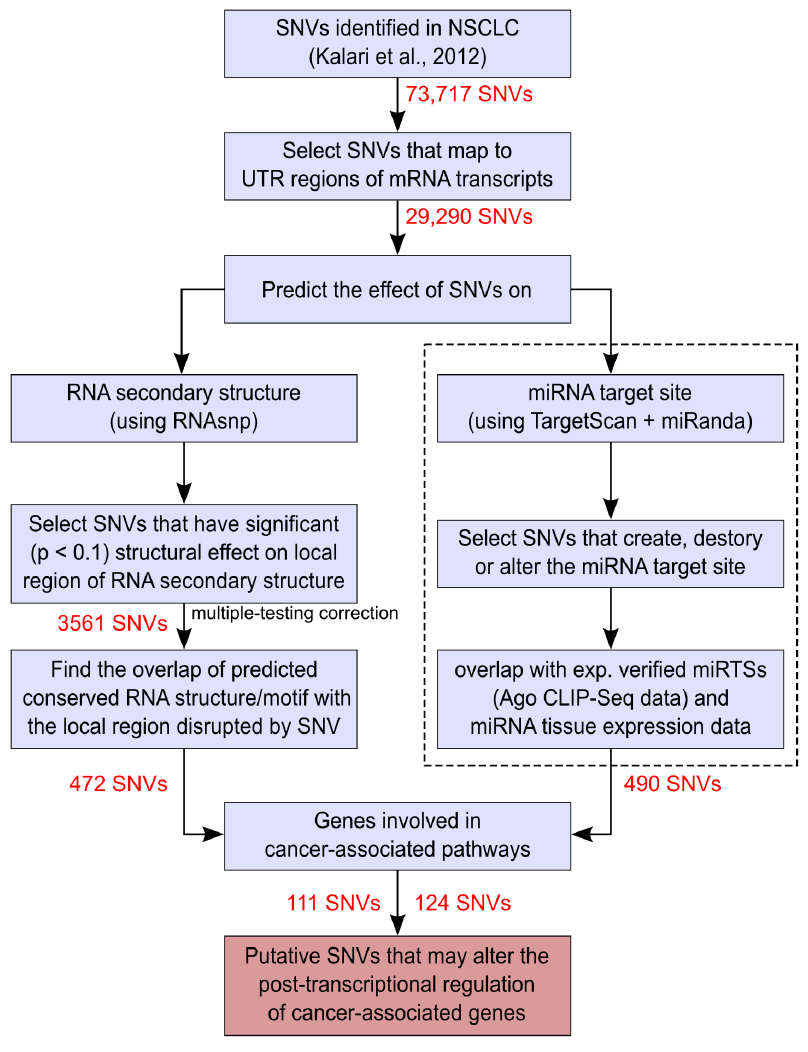
Figure 1. Pipeline for the analysis of effect of SNVs on UTRs of mRNA.